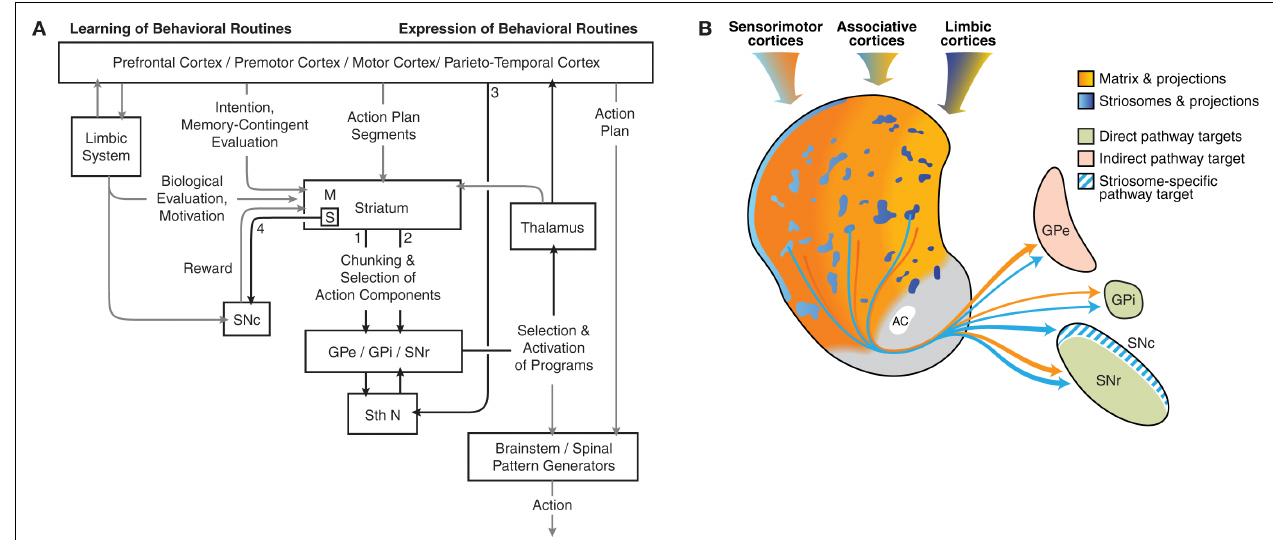
(right) to lateral (left) schematically indicates limbic, associative, and sensorimotor striatal domains. Arrows flowing into the striatum are colored to represent the relative abundance of inputs from limbic cortical regions to striosomes and from sensorimotor and associative regions to the matrix. Arrows exiting the striatum represent GABAergic efferent connections from the medium spiny projection neurons (MSNs) in the striosome and matrix compartments to their respective downstream target nuclei.The nucleus accumbens is shown in gray. GPe, external segment of the globus pallidus; GPi, internal segment of the globus pallidus (entopeduncular nucleus, in rodents); SNr, substantia nigra pars reticulata; SNc, dopamine-containing substantia nigra, pars compacta; AC, anterior commissure; STN, subthalamic